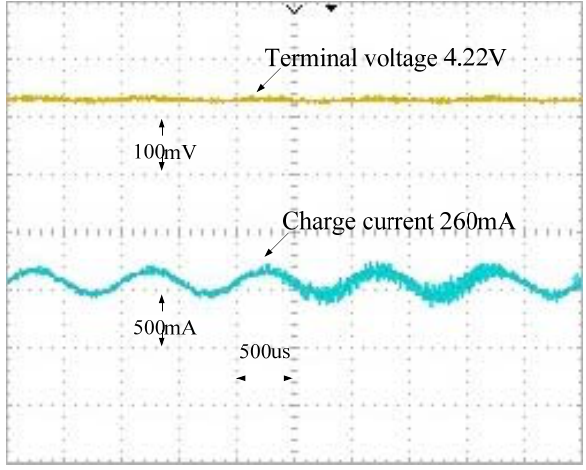
Figure 19. The measured charge current and terminal voltage waveforms at an SOC of 100%.